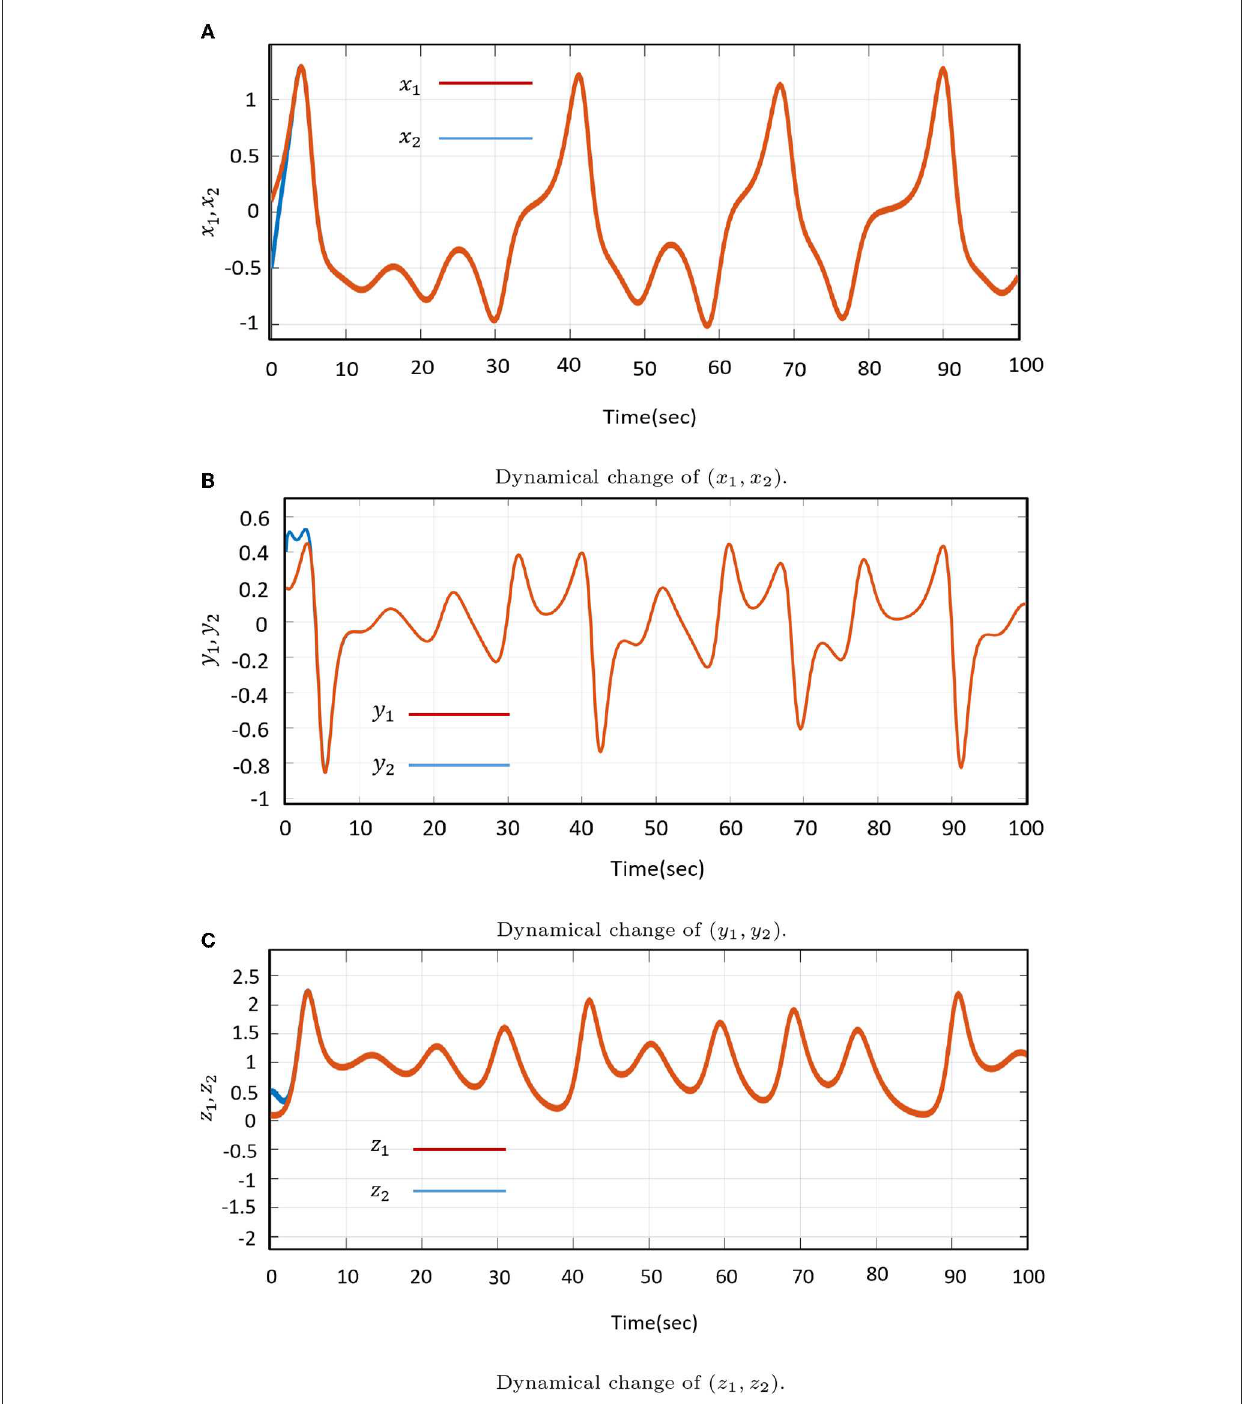
FIGURE14 Dynamical change of the states x , y , z after synchronization. (A) Dynamical change of ( x 1 , x 2 ). (B ) Dynamical change of ( y 1 , y 2 ). (C) Dynamical change of ( z 1 , z 2 ).